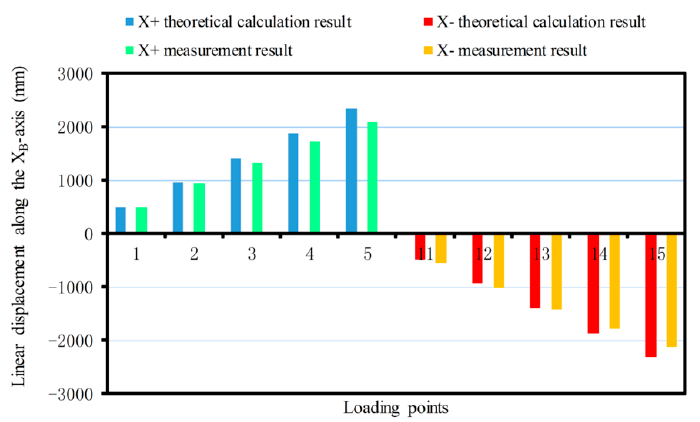
X -axis. B X -axis. X -axis. B B